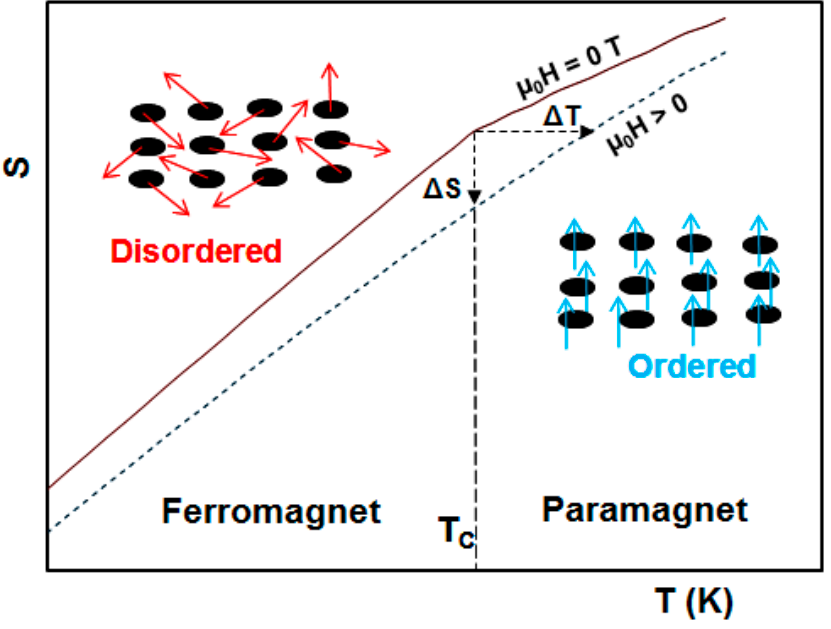
Figure 1. Principle of the conventional magnetocaloric effect (MCE).